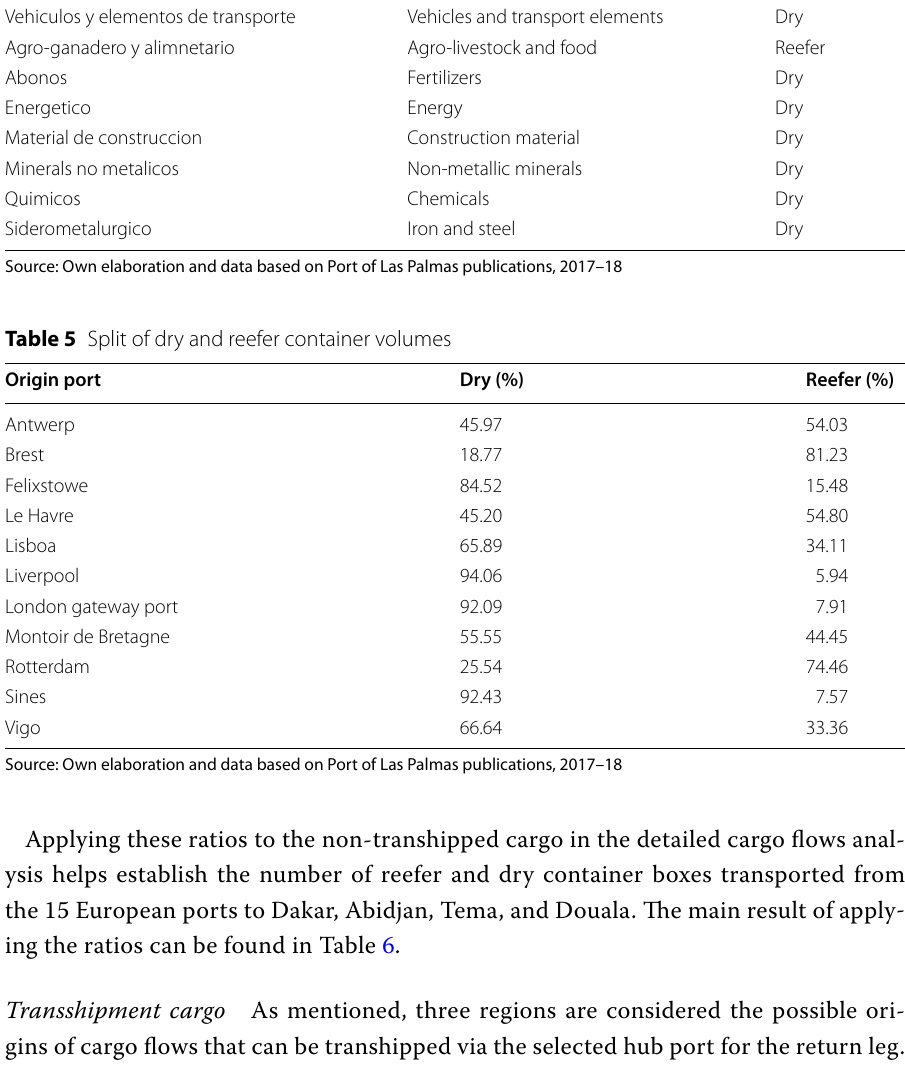
Table 4 Commodity description in containers Category (Spanish)